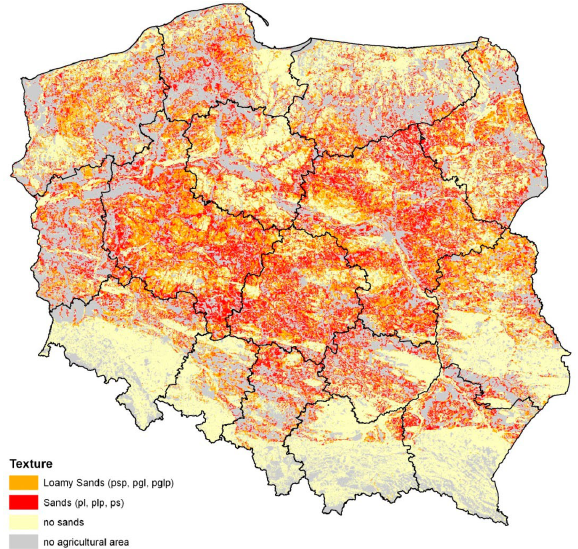
Fig. 1D. Soil texture in